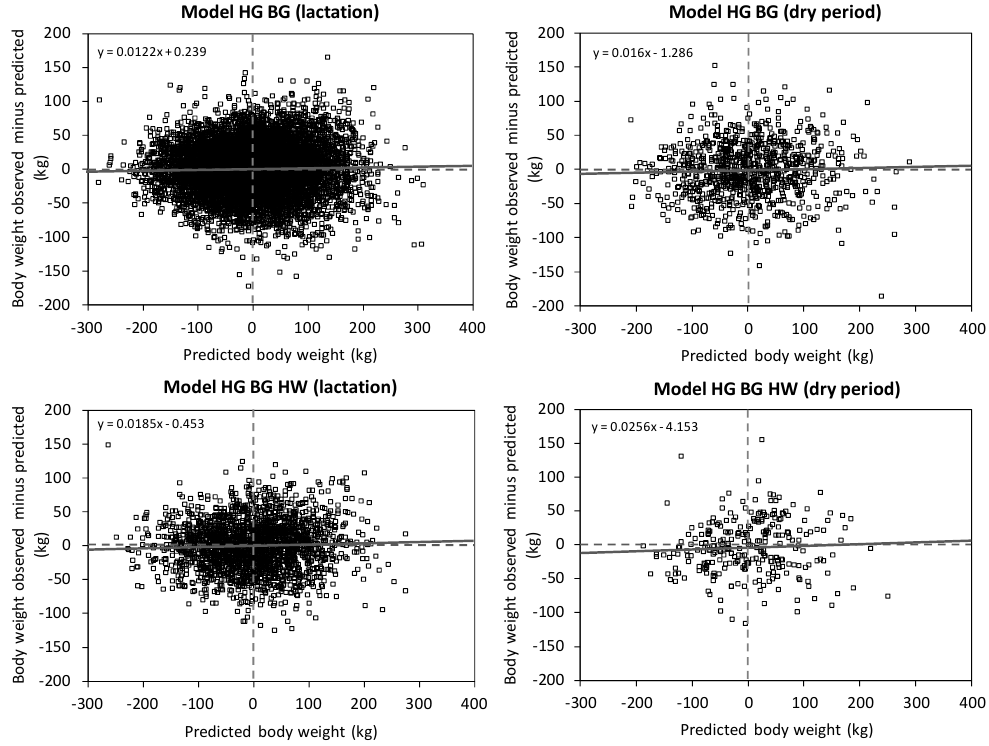
Figure 2. Decomposition of mean square prediction error (Bibby and Toutenburg, 1977) into error of central tendency (ECT, intercept), error of regression (ER, slope), and error of disturbance (ED) shown as a centralized residual plot (St.-Pierre, 2003) of the prediction equations Model HG BG and Model HG BG HW (HG: heart girth; BG: belly girth; HW: hip